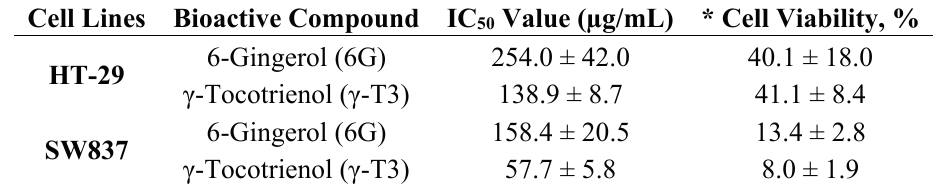
Table 1. MTS assay results for individual 6-gingerol and γ -tocotrienol treatments on each cell line. Data are expressed as mean ± SD, in three independent experiments ( n = 3).